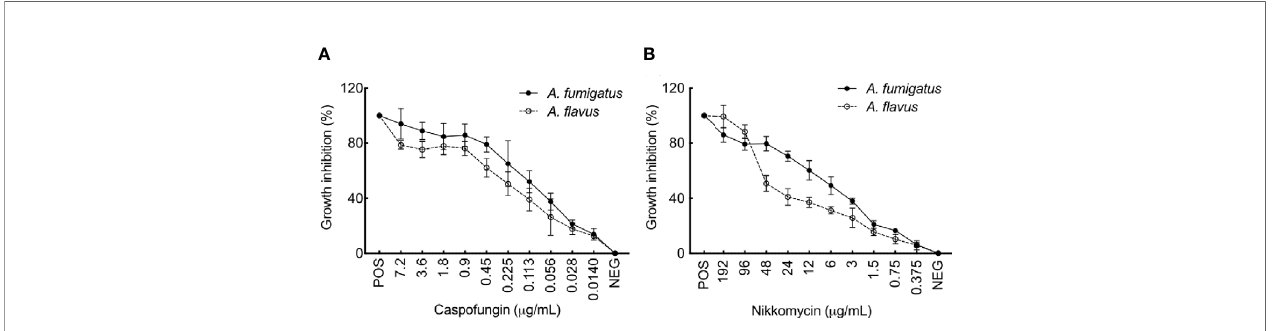
FIGURE 8 | (A) fl avus is more resistant to Caspofungin and Nikkomycin compared to A. fumigatus . Growth inhibition of A. fumigatus and A. fl avus in the presence of (A) Caspofungin and (B) Nikkomycin, as assessed by resazurin method [positive control (POS): amphotericin B (AMB; 2 mg per ml, 4 m l per well) and negative control (NEG): without any drug]. Error bar – standard